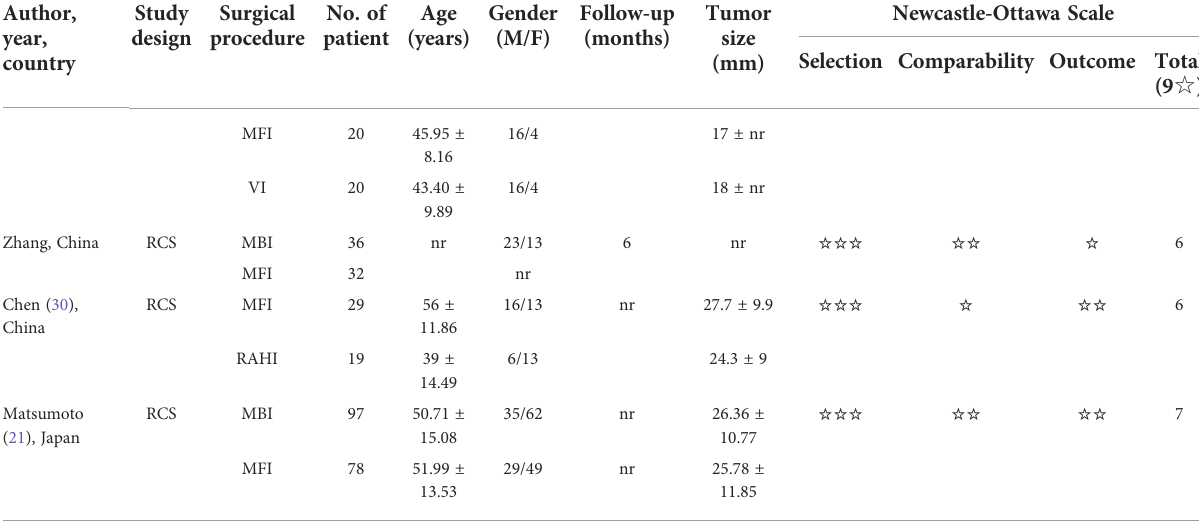
SUCRA rankings were 40% for MBI, 67% for MFI, 56% for RAHI, and 37% for VI. Comparisons of the OR between MBI vs.